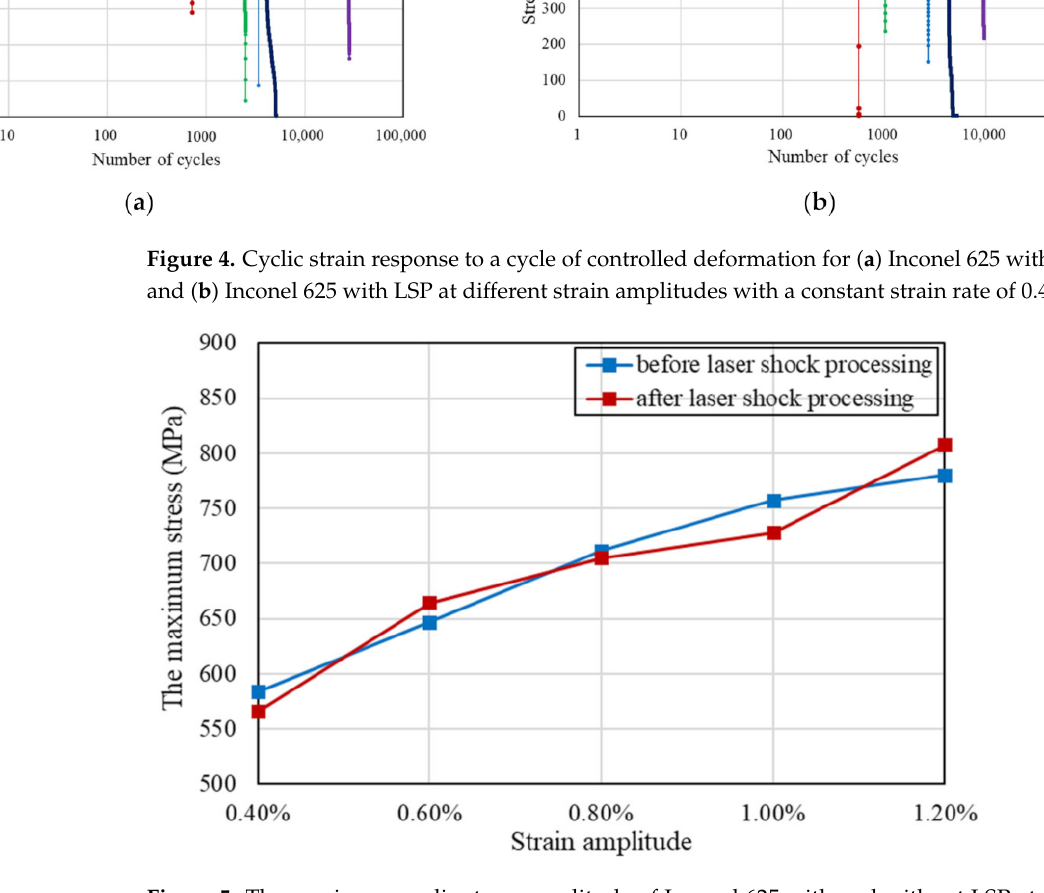
Figure 5. The maximum cyclic stress amplitude of Inconel 625 with and without LSP at different strain